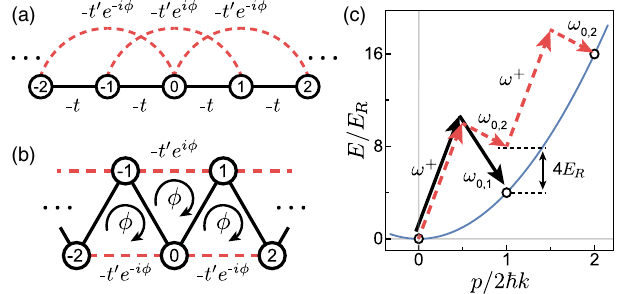
FIG. 1. Constructing the zigzag lattice. (a) The one- dimensional multirange hopping model with NN (solid black lines, t ) and NNN (dashed red, t 0 ) tunnelings. (b) The two- dimensional zigzag lattice representation, formed by a rear- rangement of the one-dimensional picture of (a). A uniform clockwise flux ϕ through each triangular plaquette is generated via NNN tunneling phases ϕ with alternating sign. (c) Atomic dispersion indicating first- (black arrows) and second-order (dashed red arrows) Bragg transitions used to couple NN and NNN lattice sites, respectively, in the momentum-space lattice. The recoil energy is given by E R ¼ ℏ 2 k 2 = 2 M Rb